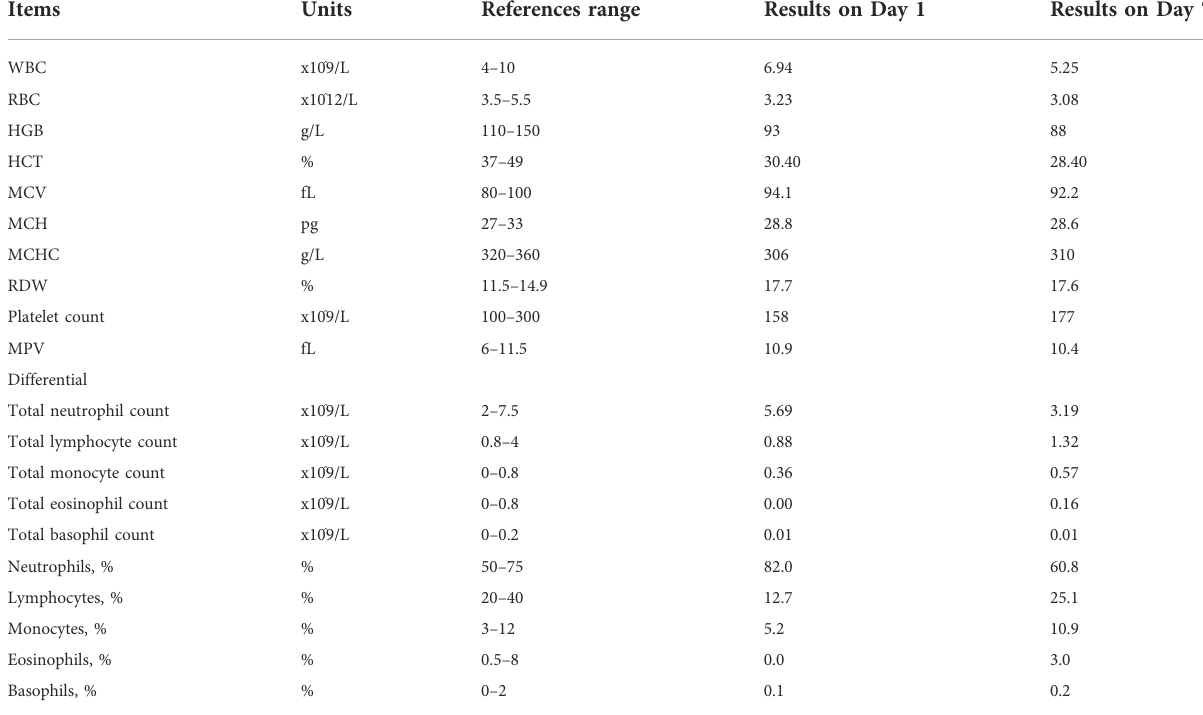
TABLE 1 Changes in laboratory results during the second